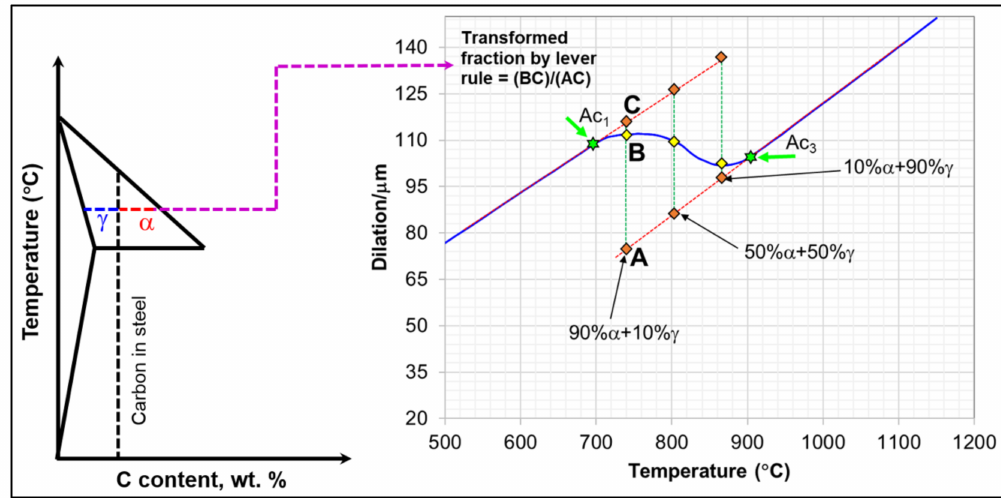
Figure 5. Determination of the annealing temperature needed to achieve 50% α + 50% γ by dilatometry and the lever